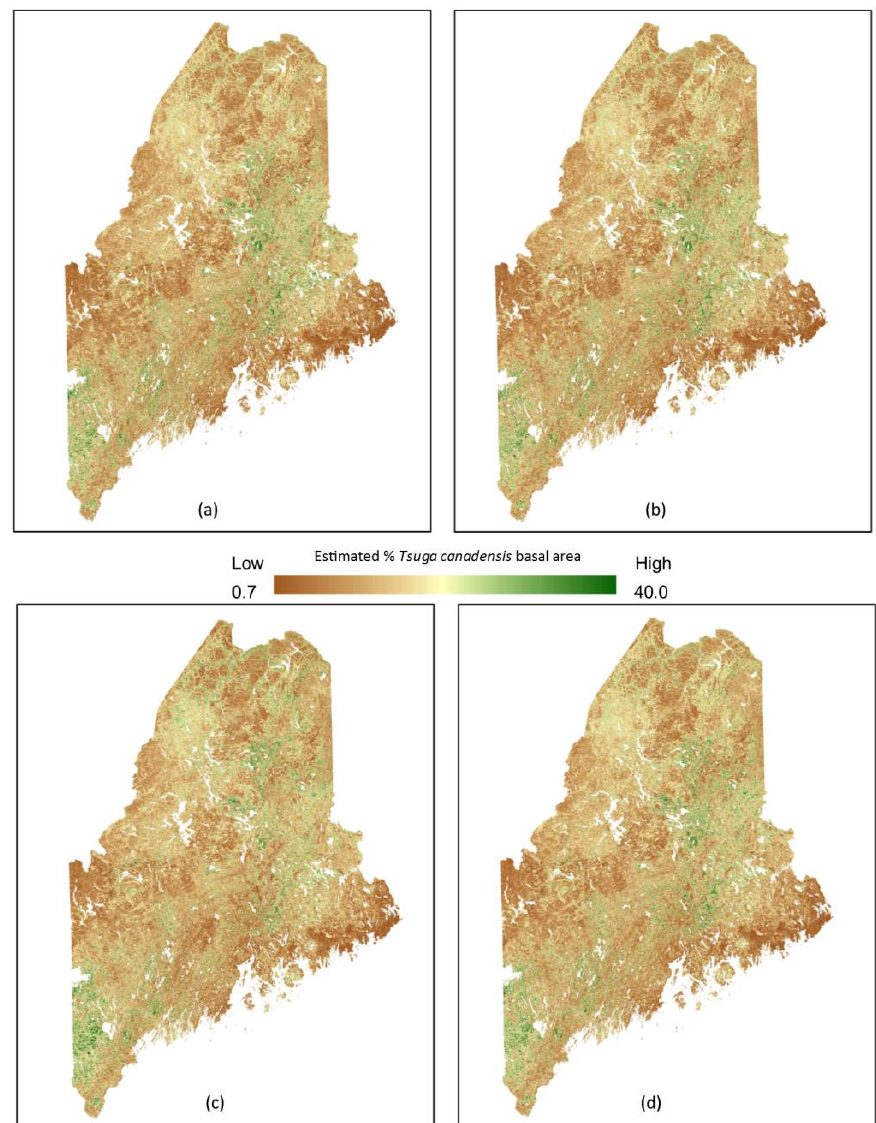
Figure 5. Predicted future distribution of Tsuga canadensis suitable habitat for various climate change scenarios including: ( a ) RCP 4.5 (2050), ( b ) RCP 4.5 2100, ( c ) RCP 8.5 (2050), and ( d ) RCP 8.5 (2100).